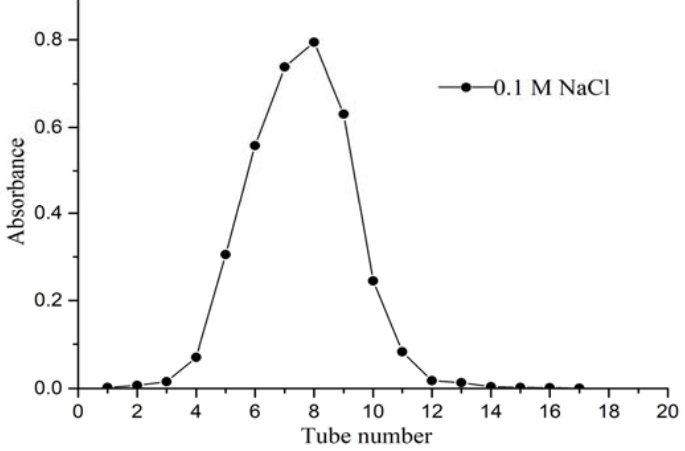
Molecules 2022 , 27 , x FOR PEER REVIEW 4 of 13